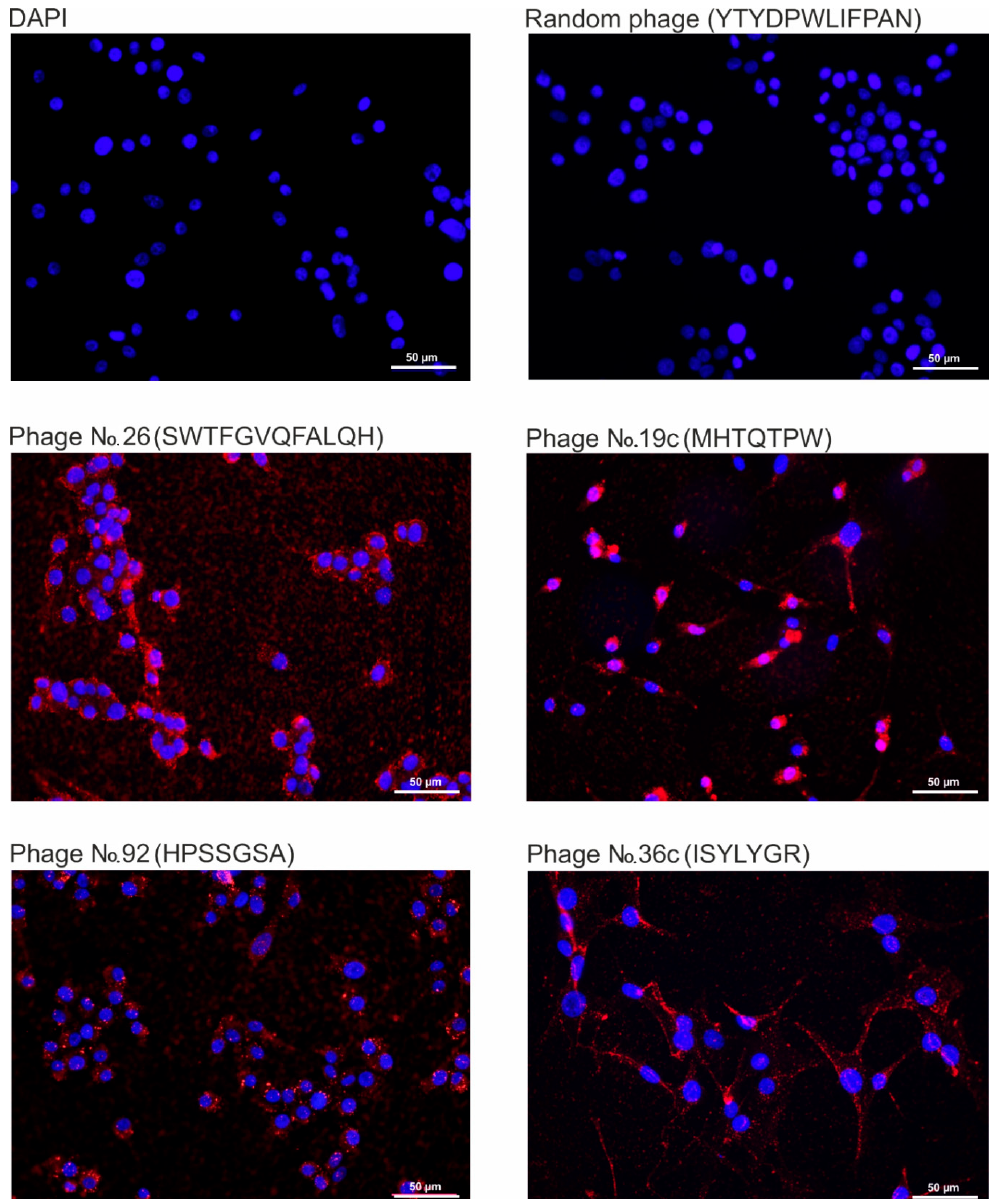
Figure 3. Fluorescence microscopy of U-87 MG cells incubated with bacteriophages No. 26, 19C, 92, 36C, displayed the peptides SWTFGVQFALQH, MHTQTPW, HPSSGSA, ISYLYGR, respectively. Microscopy was performed using anti-M13 g8p monoclonal antibody and anti-Mouse IgG (H + L) Alexa Fluor 647. DAPI was used to visualize cell nuclei. DAPI—DAPI stained U-87 MG cells not incubated with phage.